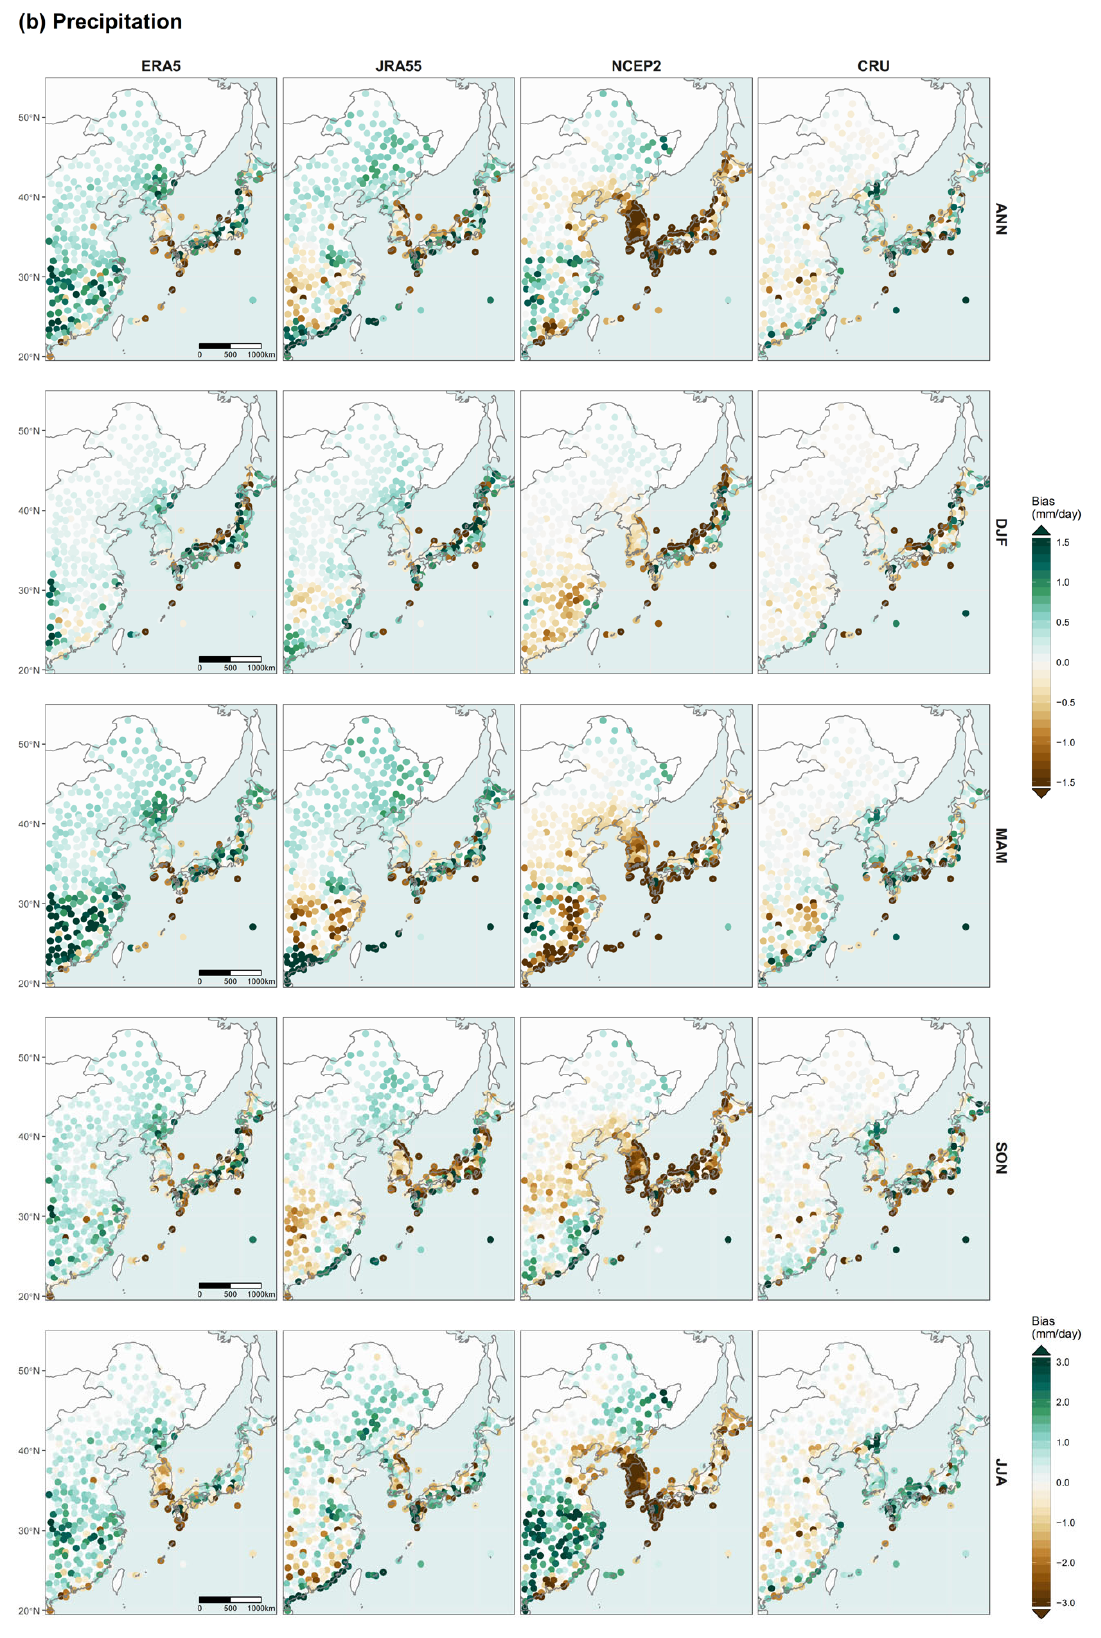
Figure 6. Same as in Figure 5, but with bias of ( a ) temperature and ( b ) precipitation. The scale of precipitation in JJA ( b ) is different from that of other seasons.